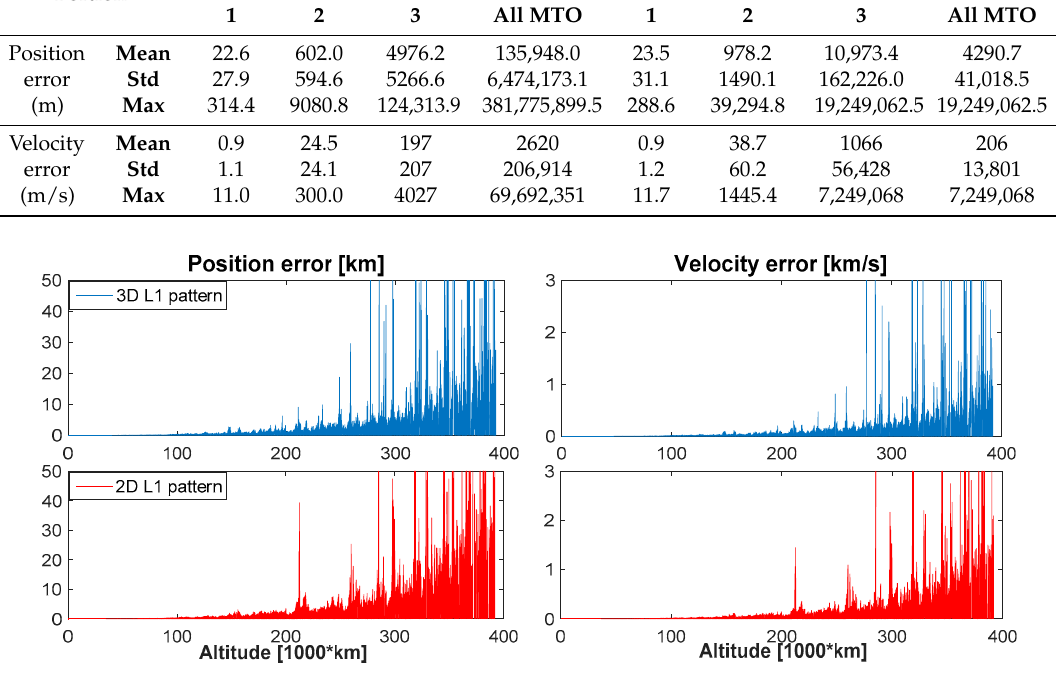
Figure 17. Single-point least squares estimation error for the assumed MTO. Table 4. Statistics of the single-point least squares estimation error.